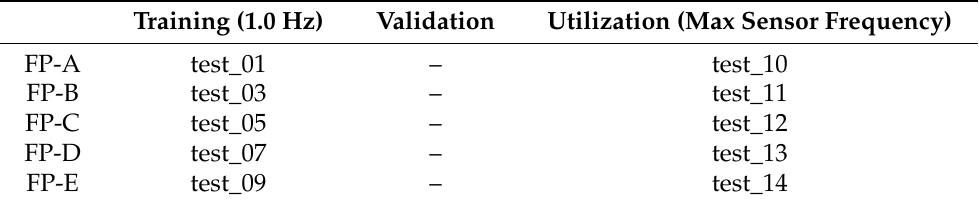
Table 2. Outdoor flight profiles from Section 4.2 were split into a “training” set (to create the GPR map) and a “utilization” set (to analyze attitude estimation). Each flight profile contributes a single training flight and a single utilization flight.